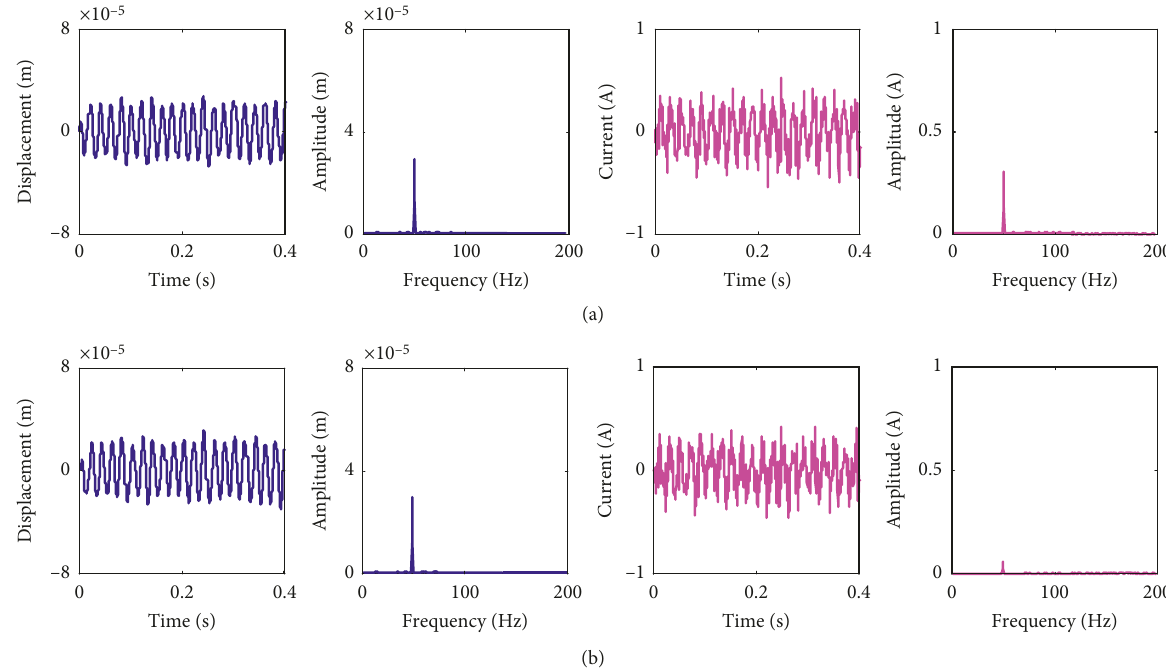
Figure 7: Comparison of vibration response at 3000rpm (a) without unbalance control and (b) with unbalance control.